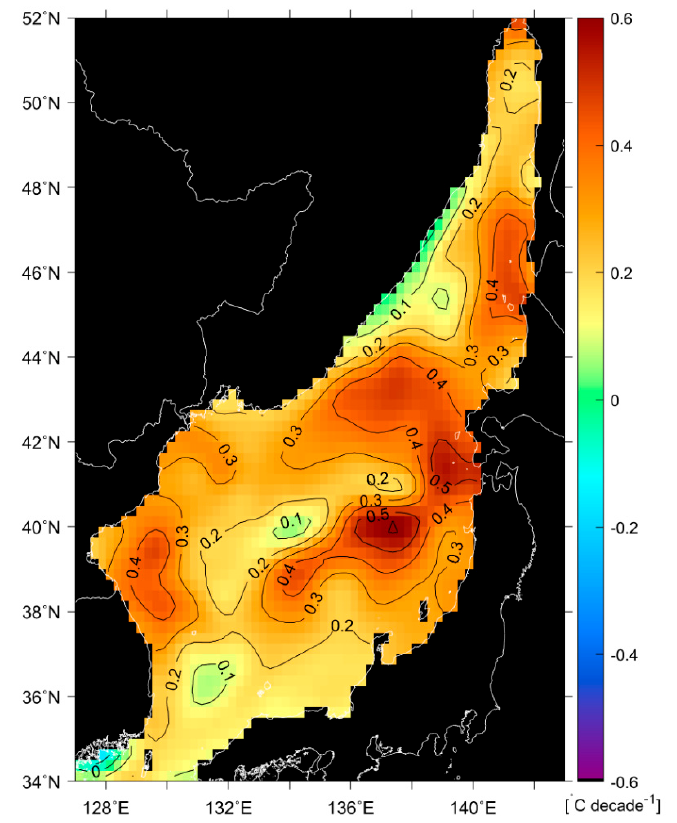
Figure 4. SST trends (°C decade –1 ) for the observation period from 1982 to 2018.